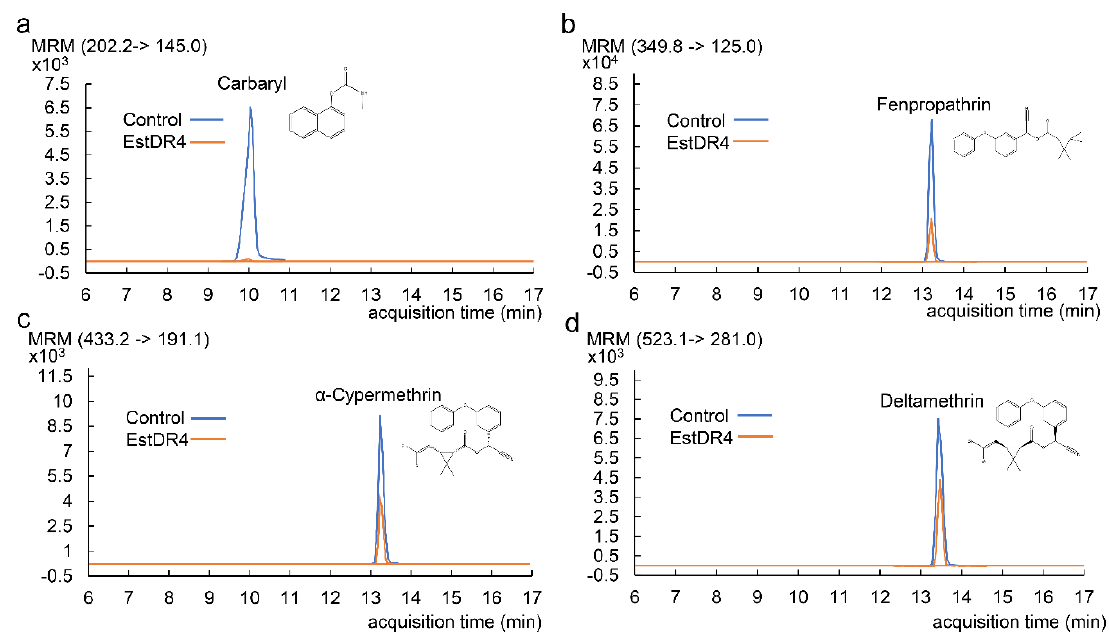
Figure 7. Degradation of insecticides by EstDR4. ( a ) carbaryl; ( b ) fenpropathrin; ( c ) α -cypermethrin; ( d ) deltamethrin. The initial concentration of carbaryl was 5 μ g·mL − 1 , the concentration of EStDR4 in the experimental group was 42 μ g·mL − 1 , while the control group was replaced with the same concentration of boiled inactivated EstDR4.